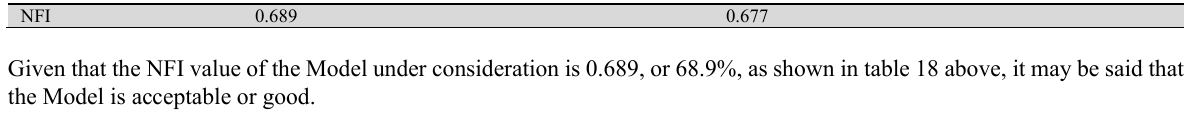
Fitted Models Saturate Model Estimate Model NFI